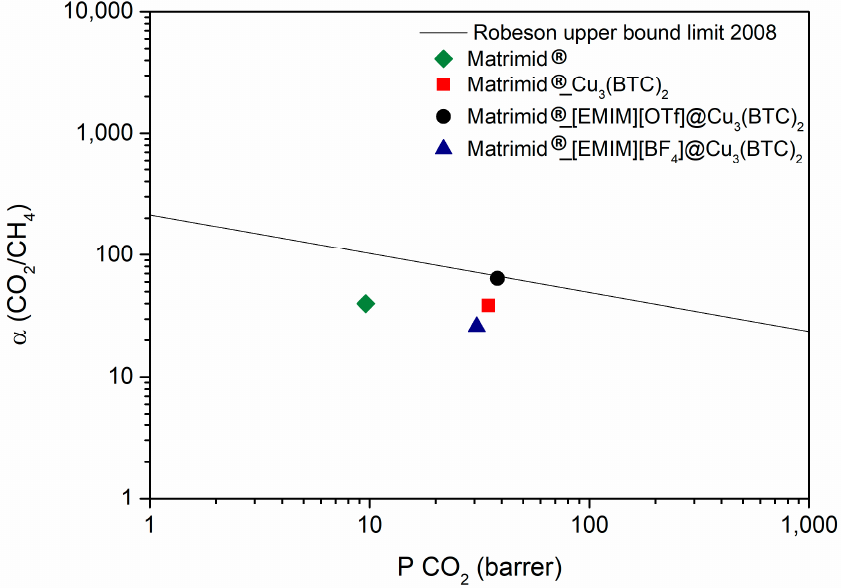
Figure 9. CO 2 /CH 4 ideal selectivity as a function of CO 2 permeability for the MMMs prepared. Comparison with the 2008 Robeson upper bound for CO 2 /CH 4 separation [21].